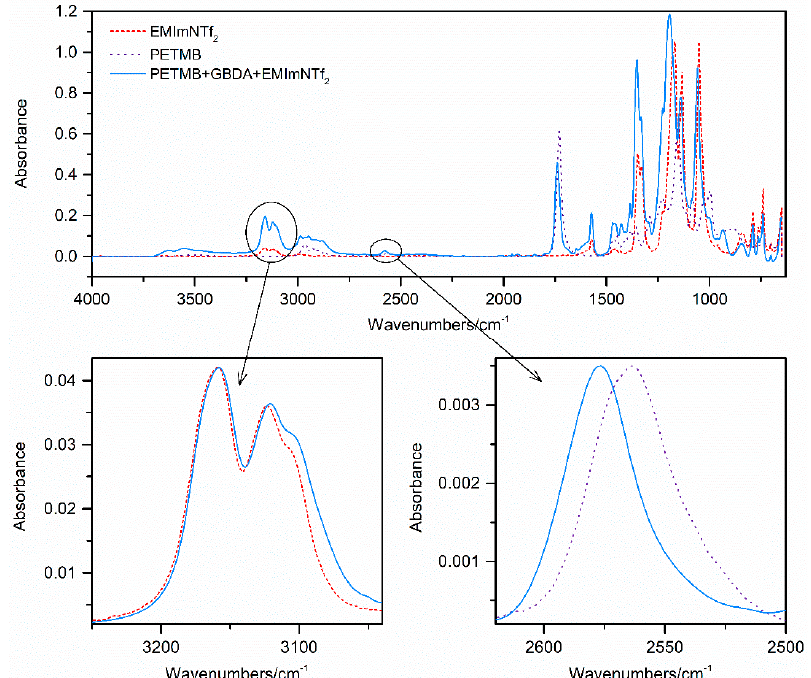
Figure 1. FTIR spectra of pure thiol PETMB, pure ionic liquid EMImNTf 2 , and a mixture of PETMB with ene GBDA and ionic liquid with presented shifts of absorption bands of the SH group of the thiol and C2–H of the imidazole ring. The absorbance of the spectra has been normalized for shift calculations of the studied SH and C2–H